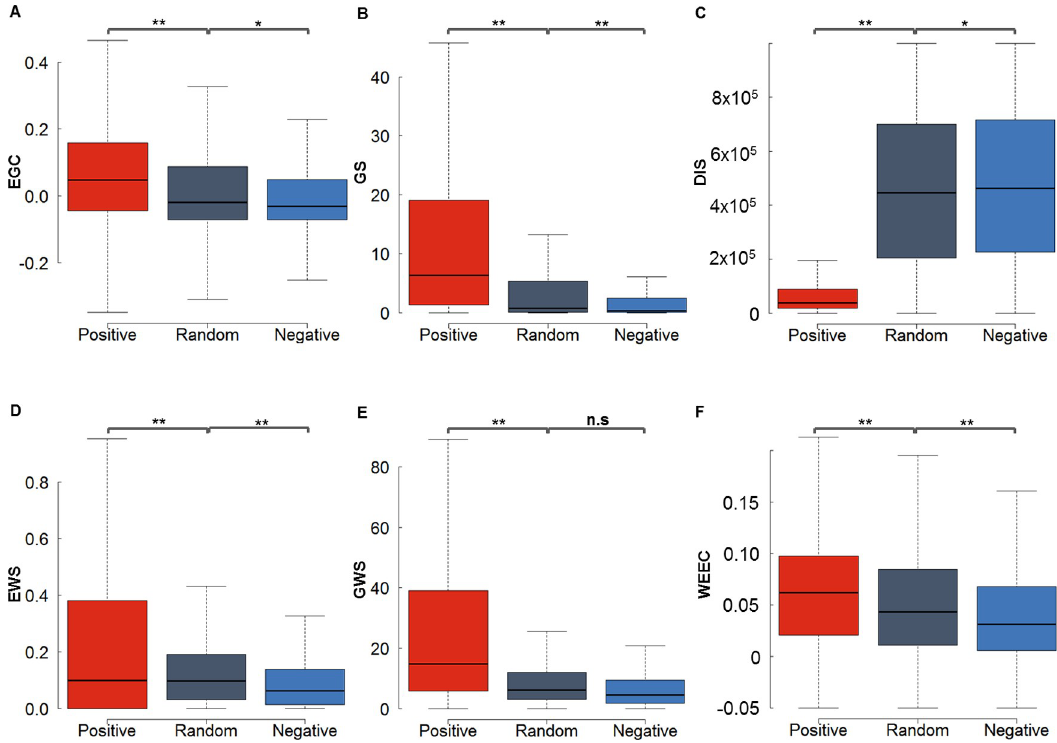
Fig 2. Six discriminative features based on the ChIA-PET data from K562. (A) Enhancer activity and gene expression profile correlation (EGC). (B) Gene score (GS) from the RNA-seq data. (C) Distance (DIS) between enhancer and gene in a pair. (D) Enhancer window signal (EWS) measuring the mean enhancer signal in the region between enhancer and promoter (E) Gene window signal (GWS) evaluating the mean gene expression level in the region between enhancer and promoter (F) The weight of enhancer-enhancer correlation (WEEC). The positive, negative and random EG pairs were obtained from ChIA-PET dataset in K562. The P values were calculated using the Student t -test. � P < 0.01; �� P < 1e-16; n.s. not